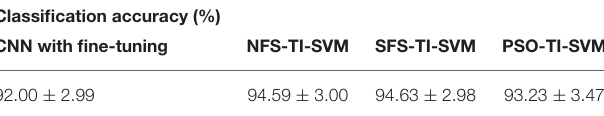
TABLE 2 | Comparison of classification accuracy of CNN with fine-tuning and TI-SVM trained with feature vectors selected by different feature selection